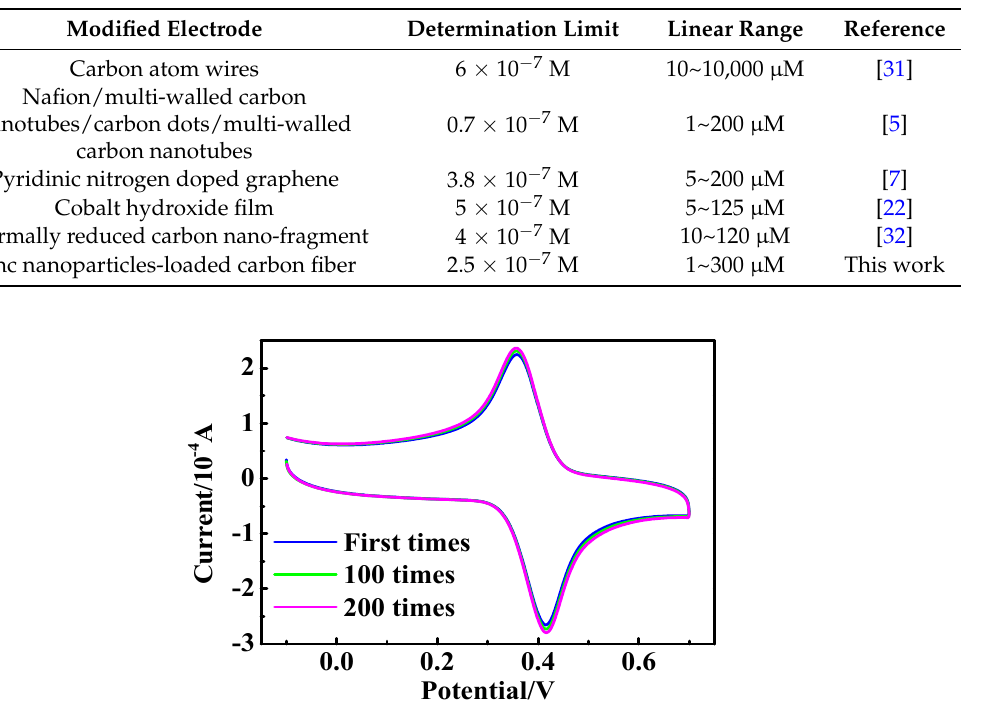
Figure 8. Circulation curves of ZCF/GCE in 0.1 M hydrochloric acid solution containing 1 mM HQ at a scan rate of 20 mV/s.